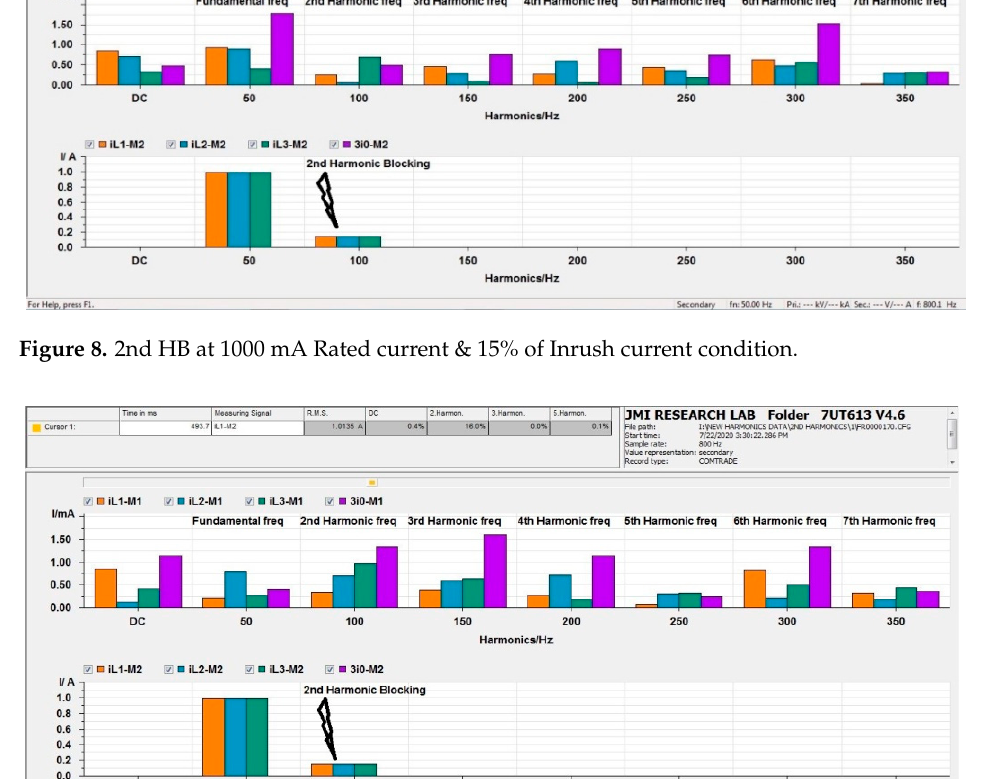
Figure 11. 2nd HB at 2000 mA Rated current & 15% of Inrush current condition.